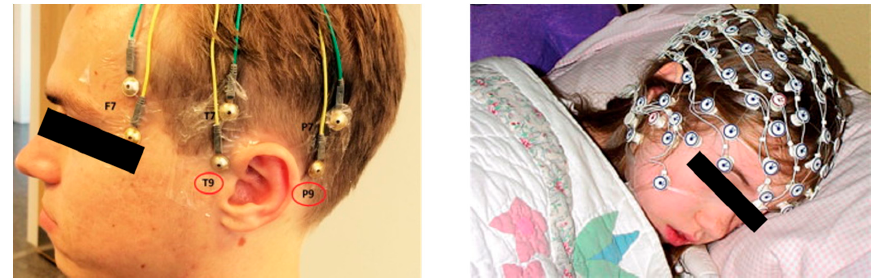
Figure 4. Cup-type passive electrodes (right, from Justesen et al. [76]) and mesh-style electrodes (left, Geodesic sensor net from Electrical Geodesics, Inc.).